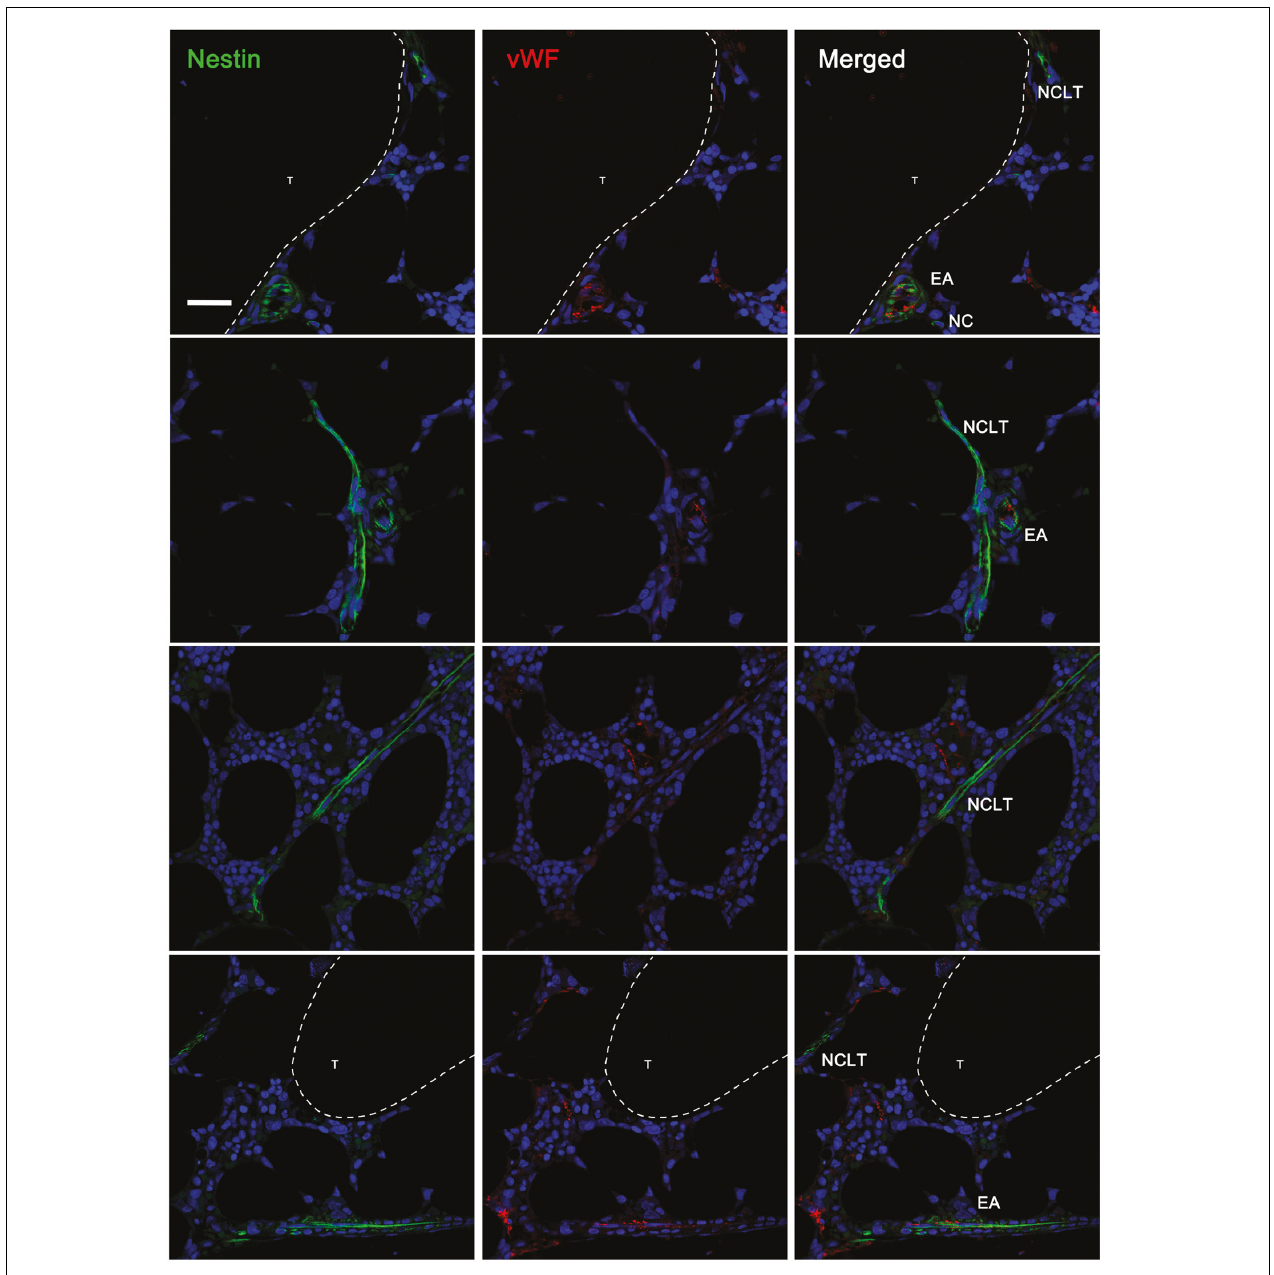
FIGURE 5 | vWF was detected only in arterial and arteriolar BMECs not in NCLTs. von Willebrand factor (vWF) was detected in a fraction of NESTIN bright (green) micro-vessels encircled by NESTIN dim perivascular cells with elongated nuclei, in particular in endosteal arterioles (EA). All NCLTs resulted negative for vWF (T = bone trabecula, scale bar: 20 µ